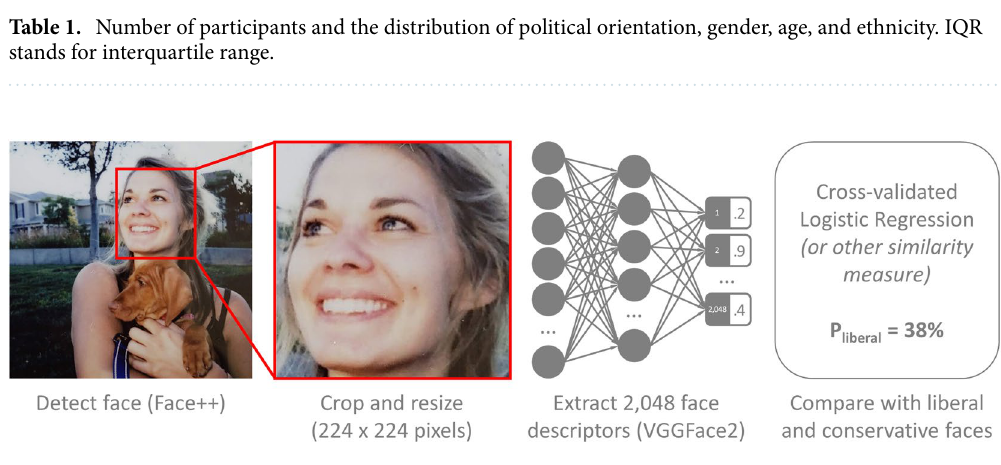
Figure 1. Procedure used to predict political orientation from facial images. (To protect participants’ privacy, we used a photo of a professional model. Their informed consent for publication was